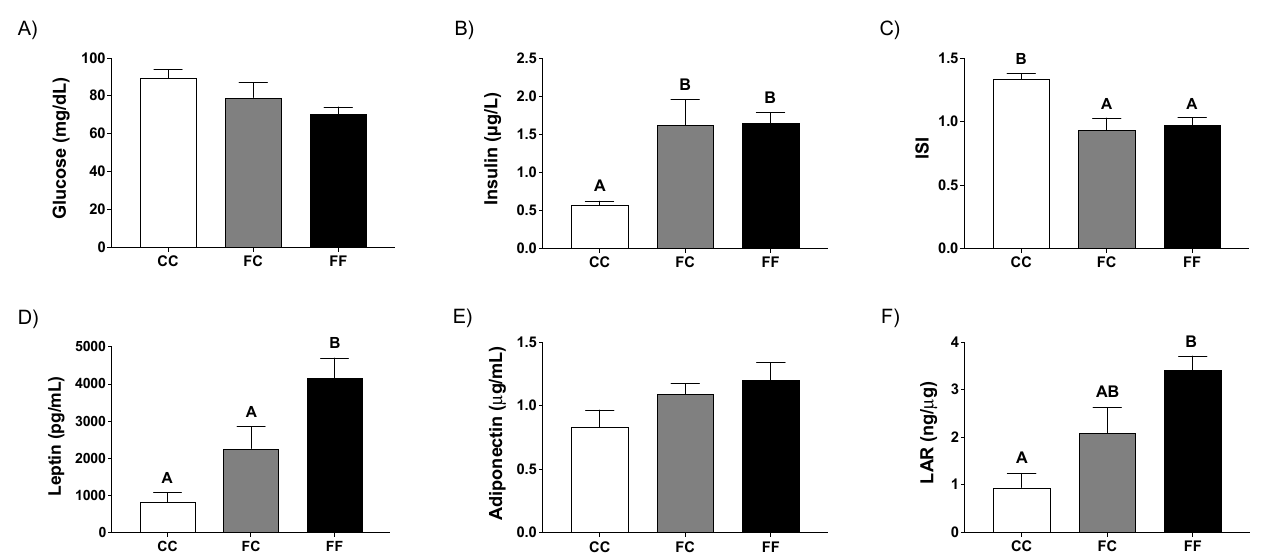
Figure 4. Pregnancy in progeny from fructose-fed mothers and ingestion of a 10% wt/vol fructose solution throughout gestation in pregnant rats from fructose-fed mothers affect fetal leptin and insulin responses. Plasma ( A ) glucose and ( B ) insulin, and ( C ) insulin sensitivity index (ISI) of fetuses from 21-day-pregnant rats from control mothers (CC, empty bar), or pregnant rats from fructose-fed mothers subjected (FF, black bar) or not (FC, grey bar) to fructose intake throughout pregnancy. Plasma ( D ) leptin and ( E ) adiponectin, and ( F ) leptin/adiponectin ratio (LAR) of fetuses from 21-day-pregnant rats from control mothers (CC, empty bar), or pregnant rats from fructose-fed mothers subjected (FF, black bar) or not (FC, grey bar) to fructose intake throughout pregnancy. Data are mean ± S.E. from n = 5 plasma pools of the fetuses of the same litter. Values not sharing a common letter are significantly different ( p < 0.05) between the three groups.